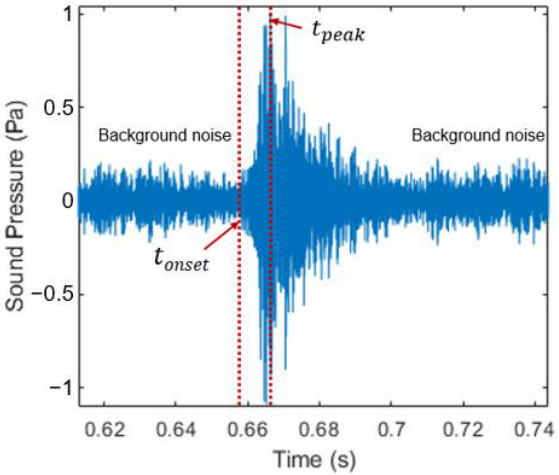
Figure 8. Time series data around a spark event.